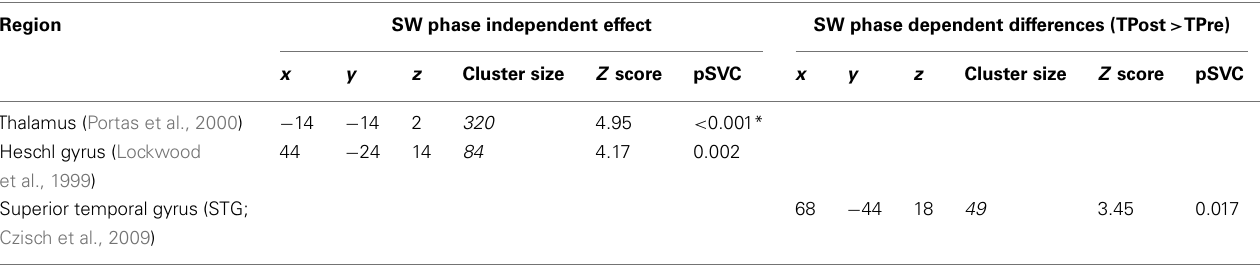
Table 1 | Brain responses to tones during deep NREM